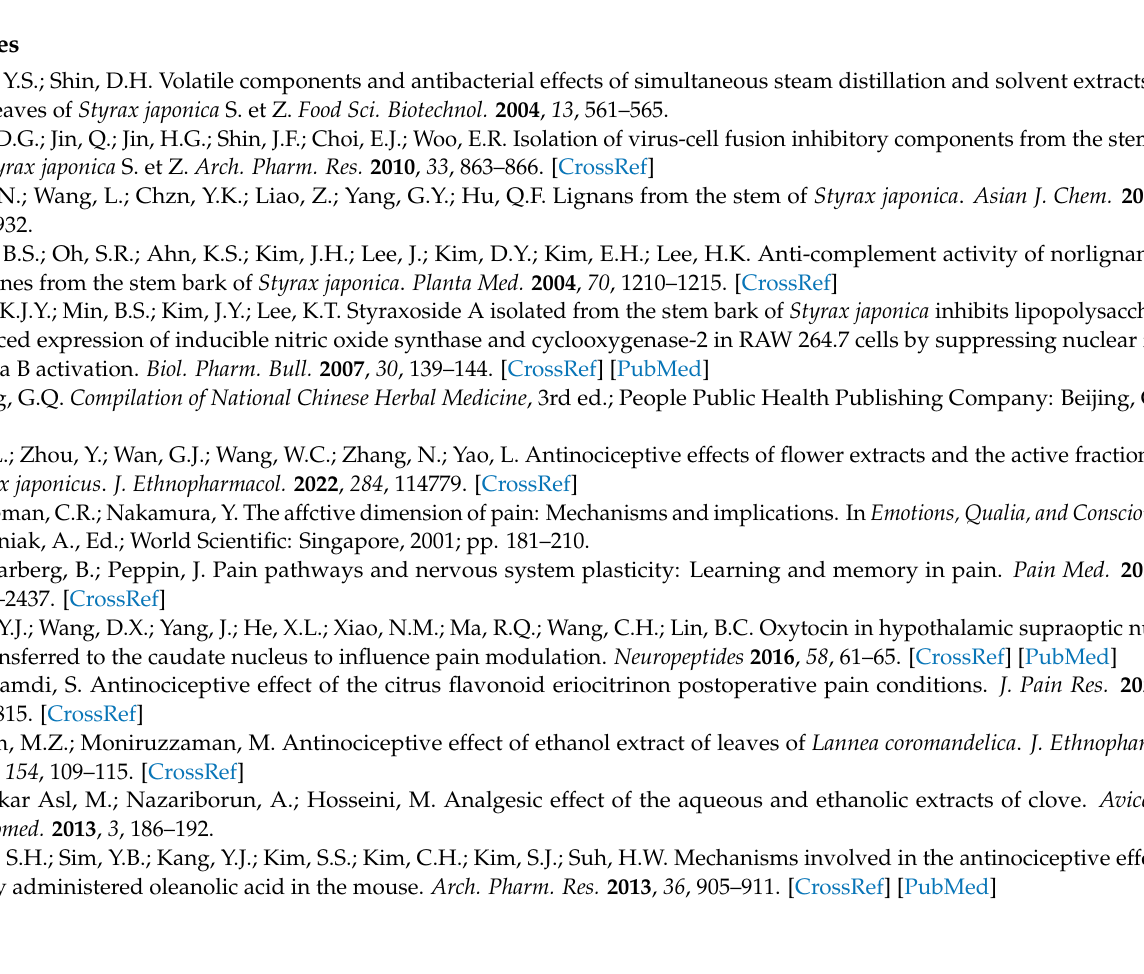
spectroscopy of compound 1 ; Figure S6: Heteronuclear multiple bond connectivity spectroscopy of compound 1 ; Figure S7: IR spectral information of compound 1 ; Figure S8: Effects of kaempferol-3-O- rutinoside, forsythin and arctiin in writhing (a) and formalin tests (b); Figure S9: The spectrum of the 1 H-QNMR of JA and